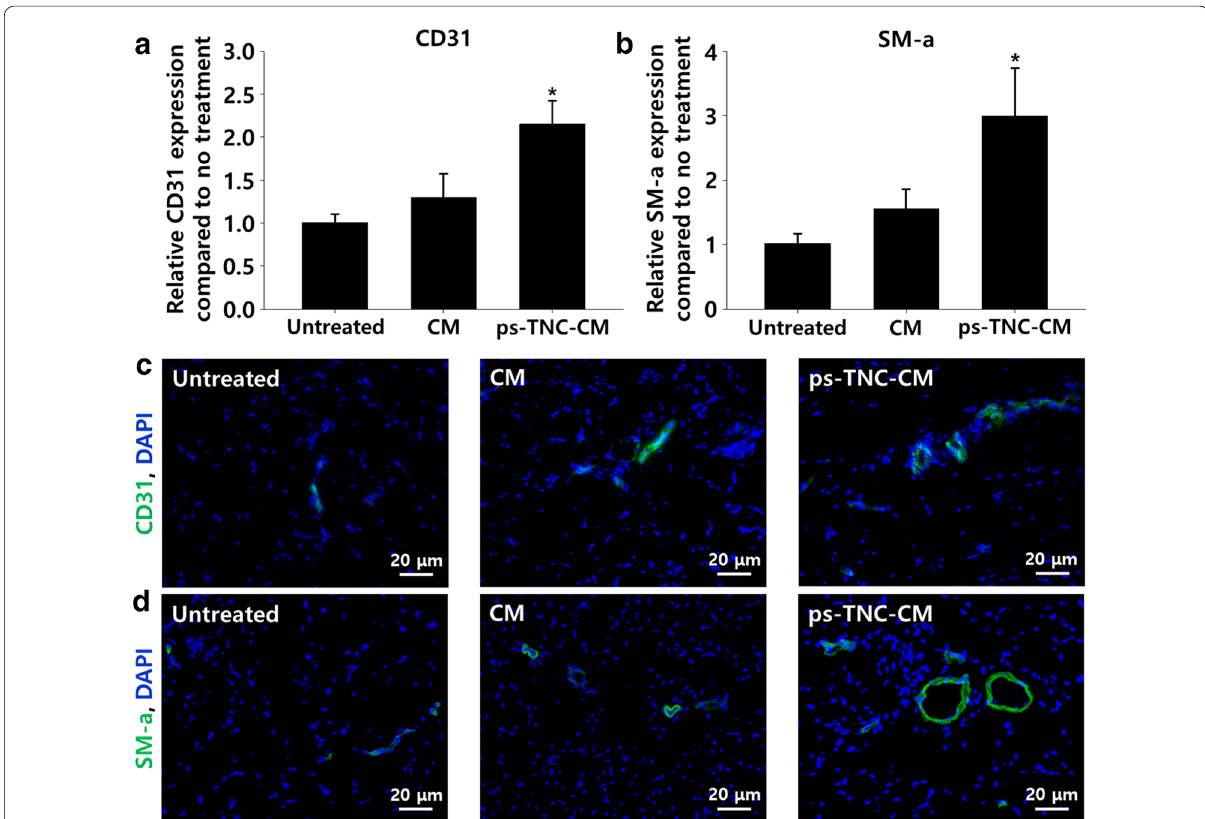
Fig. 7 Improved angiogenesis induced by ps‑TNC‑CM in a mouse hindlimb model 28 days after the treatment. a , b Analysis of representative vascular genes (CD31 and SM α‑actin) expression by qRT‑PCR near ischemic lesions (n of CD31 (green) and d SM α‑actin (green) in ischemic lesions. Blue indicates the nuclei